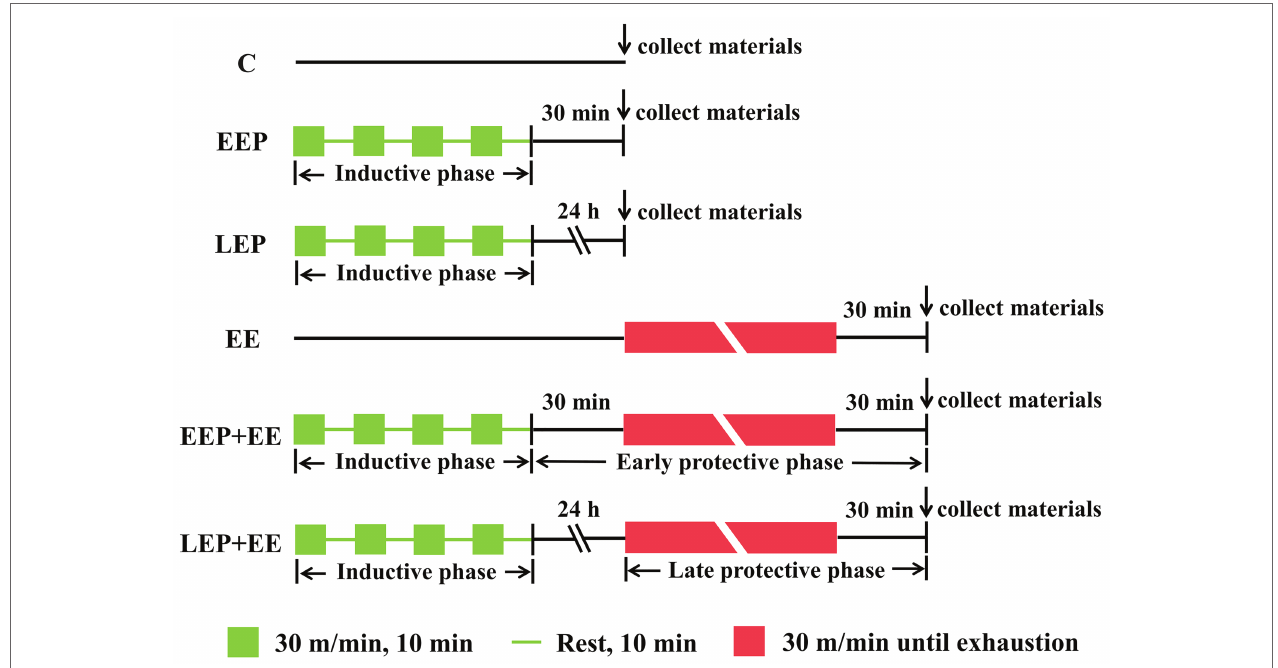
FIGURE 1 | Exercise protocol. C, group control; EEP, group early exercise preconditioning; LEP, group late exercise preconditioning; EE, group exhaustive exercise; EEP + EE, group EEP plus exhaustive exercise; and LEP + EE, group late exercise preconditioning plus exhaustive